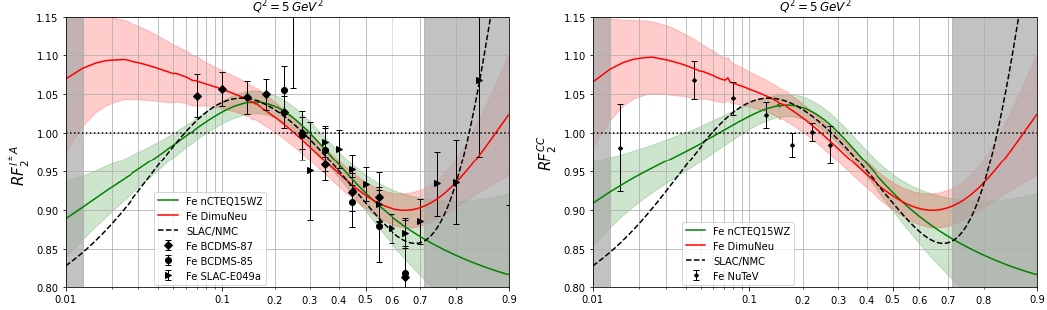
/ F N computed with nCTEQ15WZ and DimuNeu 2 2 ) / 2. For the charged lepton case = ( F ν A + F ¯ ν A 2 2 2